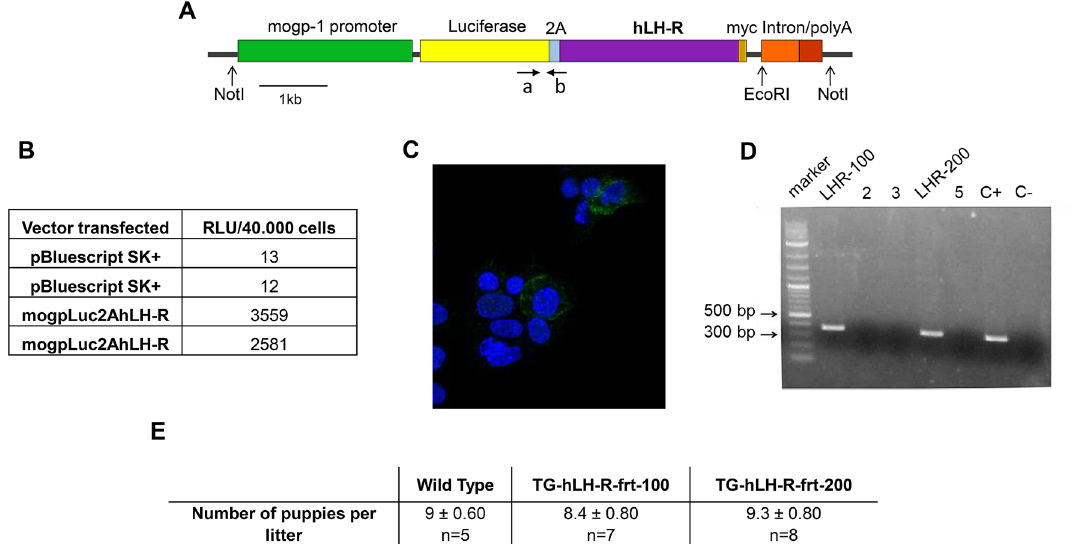
Figure 1. Generation of LH-R (TG) transgenic mice. ( A ): Scheme of the construct used for the generation of mice overexpressing LH-R. The LH-R and the Luciferase cDNA sequences are inserted in frame, separated by a specific viral sequence (2A sequence), allowing the production of the two single proteins in an equimolar manner. The unique site of digestion for Southern blot analysis (EcoRI) is reported. The primers used for the screening of TG mice mapping on the cDNA are indicated as a and b. ( B ): Luminescence data obtained after transfection of Hec1A cells with the pBluescript SK(+) vector containing the mogpLuc2AhLH-R transgenic construct or with an empty vector. The results of two different transfections are shown. Luciferine undergoes a luciferase-catalysed oxidation resulting in an excited state that emits upon decaying to its ground state. The resulting sample light output is measured by using a current-measuring luminometer whose output is expressed as arbitrary light units, usually referred to as “Relative Light Units” (RLU). ( C ): Confocal microscope images showing the presence of LH-R on the membranes (green spots) of Hec1A cells transfected as in ( B ). Staining with primary Ab anti-myc (1:100) and secondary Ab-Alexa 488 (1:500). The nuclei are counterstained with DAPI. ( D ): End point PCR on DNA extracted from tails of different puppies. Bands of the expected molecular weight (350 bp) are evident in two mice: lane 1 (LHR-100) and lane 4 (LHR-200); C+ is the vector that serves as positive control; C- is the negative control. ( E ): Summary table of pregnancy frequency: the mean number ± SEM of mice for each litter and the number of litters (n) for each mouse line (transgenic and WT) is